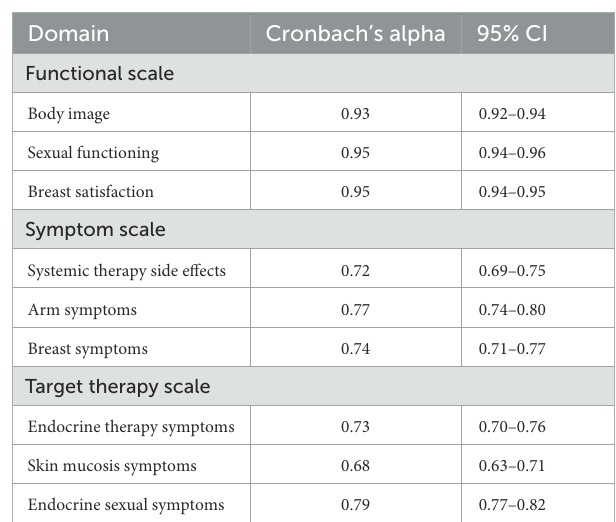
TABLE 6 Cronbach’s alpha of each domain of the Indonesian EORTC QLQ